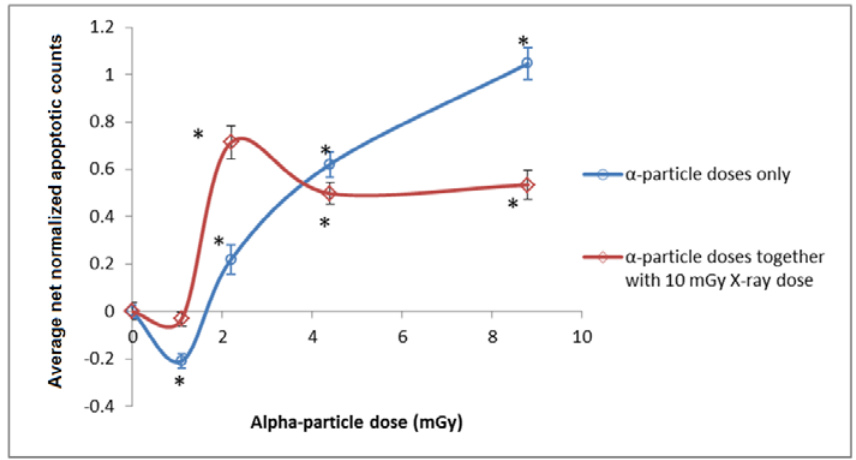
Figure 1. Net normalized apoptotic counts: (i) N AY + and N Ac + , (ii) N AXY + and N AXc + on 24-hpf zebrafish embryos which have been irradiated with (i) alpha-particle dose only, and (ii) alpha-particle dose + 10 mGy X-ray at 5 hpf. Error bars represent the standard errors. The lines joining the data points are drawn to guide the eye only. Comparisons are separately made for the five data points within case (i) or case (ii) through ANOVA. When p ≤ 0.05 from ANOVA, post -hoc t -tests are further performed to assess the difference between tested A Y or AX Y groups and the corresponding A C or AX C group. Significant differences from post-hoc t -tests are asterisked in Figure 1. * Statistically significant differences between the tested A Y or AX Y group and the corresponding A C or AX C group.